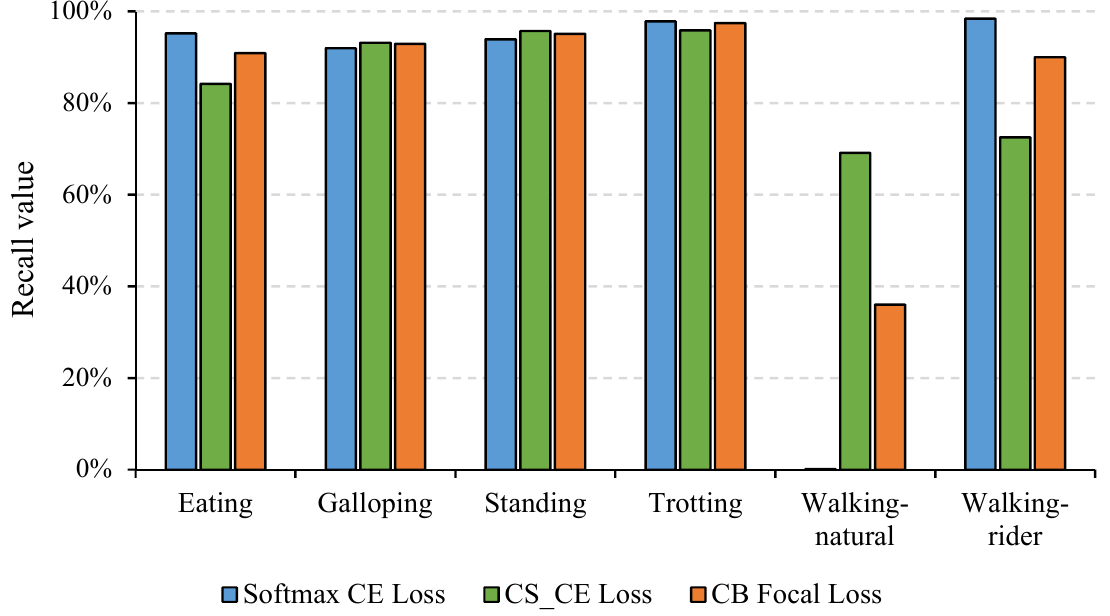
Figure 6. Recall of different activities under different loss functions including softmax CE loss, cost-sensitive cross-entropy (CS_CE) loss, and CB focal loss.